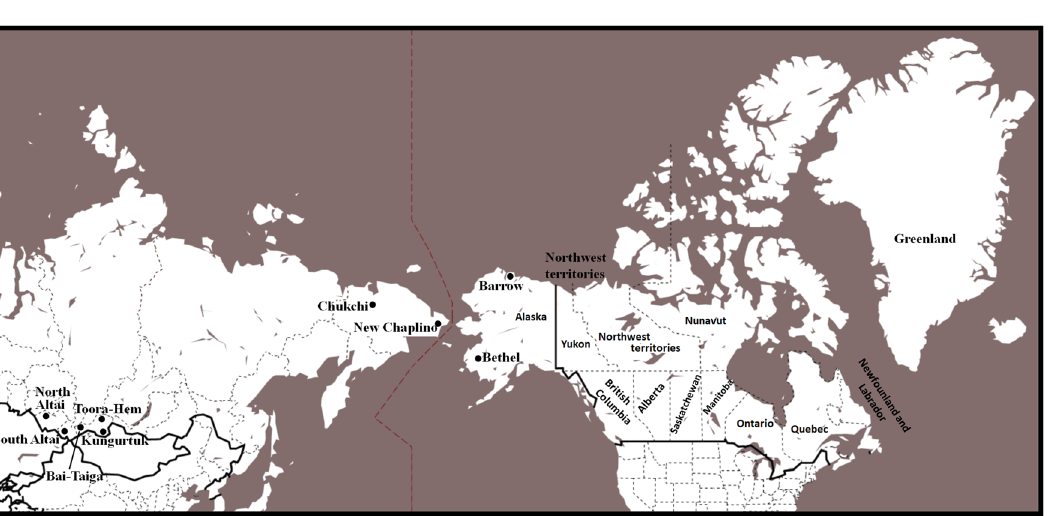
Figure 1. Geographical location of populations